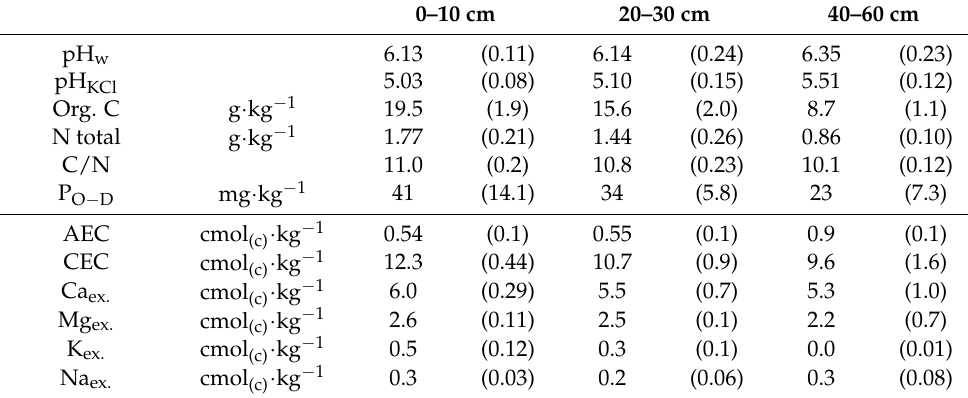
Table 2. Physical and chemical characteristics of the studied soil before the experiment; standard de- viations ( n = 6) are in brackets. P O-D : exchangeable phosphorus (Olsen–Dabin method); AEC: anionic exchange capacity; CEC: cationic exchange capacity; DCB: dithionite-citrate-bicarbonate; ox.: